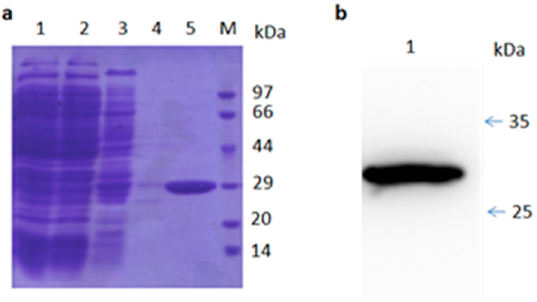
Figure 3. SDS-PAGE and Western blot analysis of purified TR2-3. ( a ) SDS-PAGE analysis of the TR2-3 protein purification by Ni-sepharose column. Lane 1 shows the supernatant of ultrasonic lysed bacterial cell induced by 0.5 mM IPTG overnight; Lane 2 shows flow through; Lane 3 is the elution with 50 mM of imidazole; Lane 4 is the elution with 100 mM imidazole; Lane 5 is the elution with 500 mM of imidazole; and M is the molecular weight marker; ( b ) Western blot analysis of purified TR2-3. Lane 1 shows the purified TR2-3. These data are representative of at least three independent experiments.